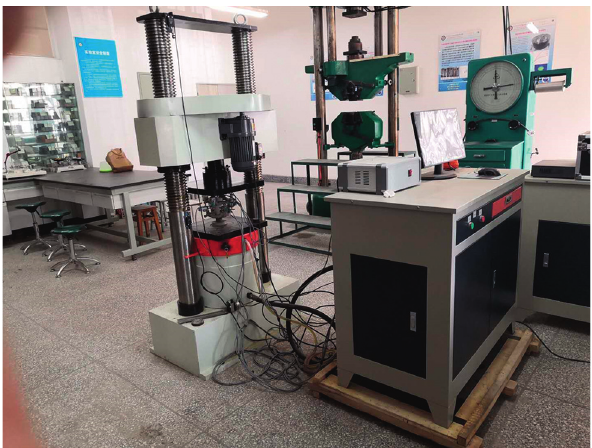
Figure 6: YAW-2000 computer-controlled automatic pressure testing machine. Table 1: Rock parameters obtained from the uniaxial compressive test under various